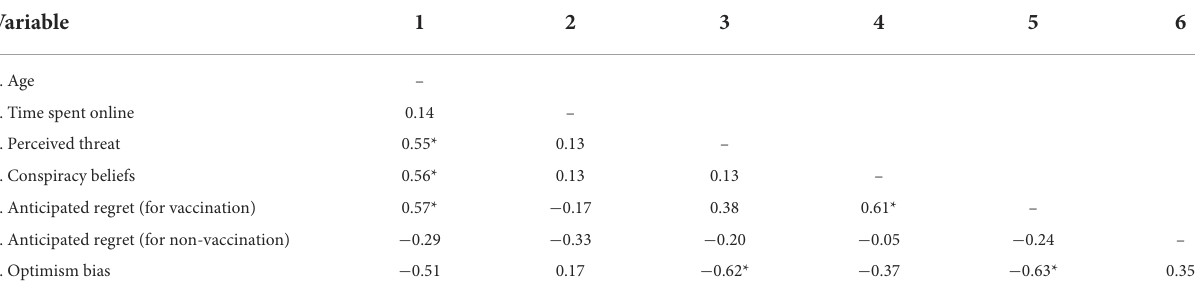
TABLE 2c Associations between the main variables ( N = 15, participants who will definitely vaccinate against COVID-19).